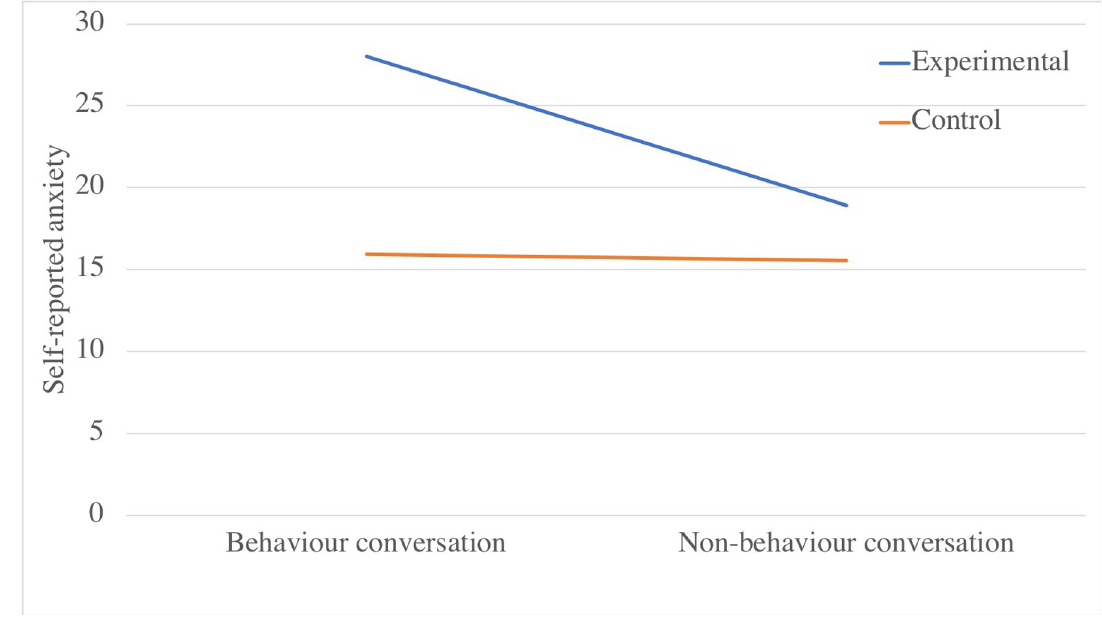
Fig 2. Interaction effect of participant type and conversation type on self-reported anxiety.